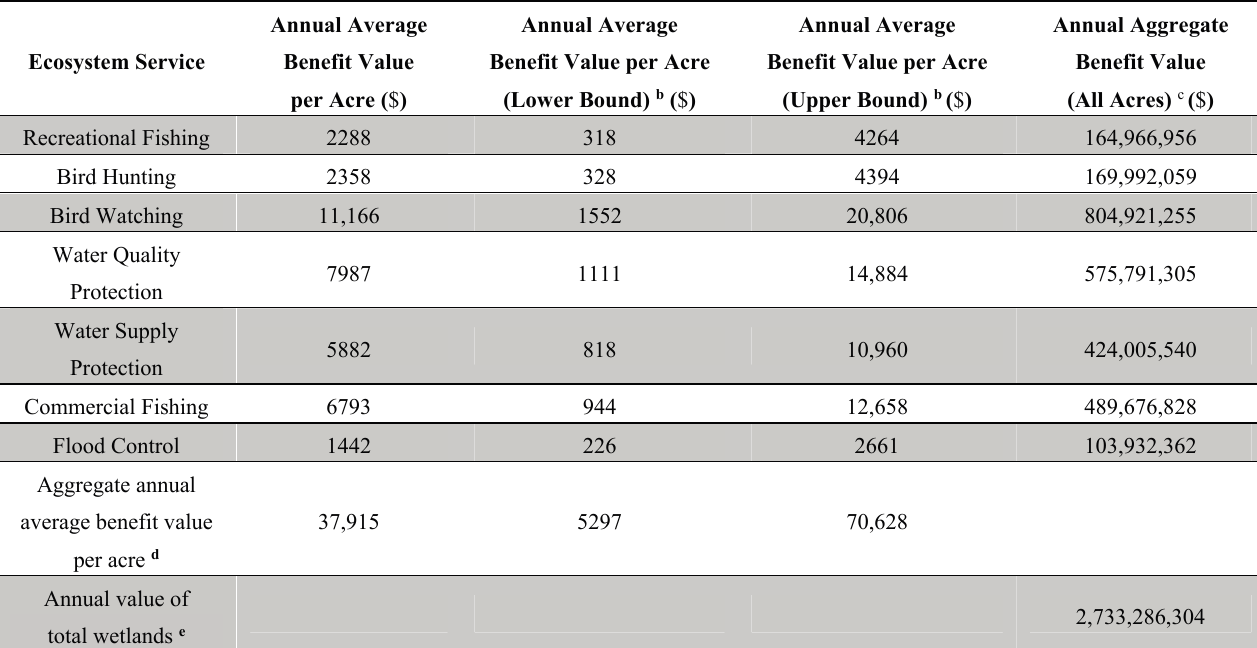
Table 3. National annual average benefit value per acre for individual ecosystem service and aggregate value for ecosystem service per year produced by wetlands mitigation required under Section 404 of the Act a